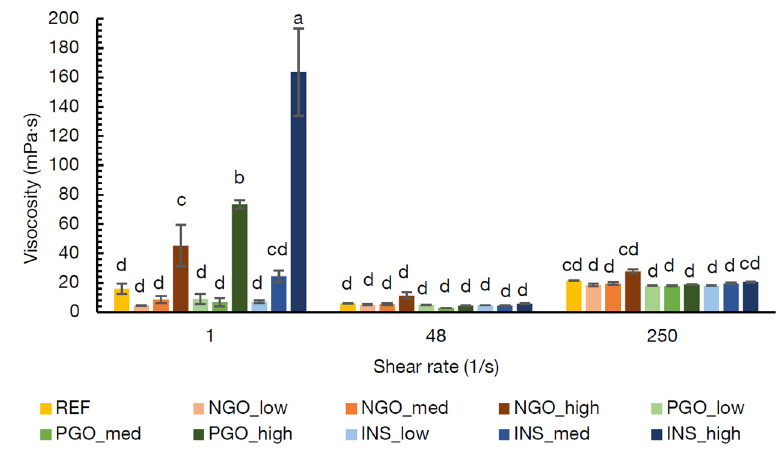
Figure 3. Viscosities 60 °C of instant soups containing potato starch (REF) or non-gelatinised (NGO), pre-gelatinised (PGO) or commercially available pre-gelatinised (INS) chickpea flour at low, medium (med), and high concentrations (Table 1) at different shear rates. Viscosity values indicated with the same letter are not significantly different ( α = 0.05).